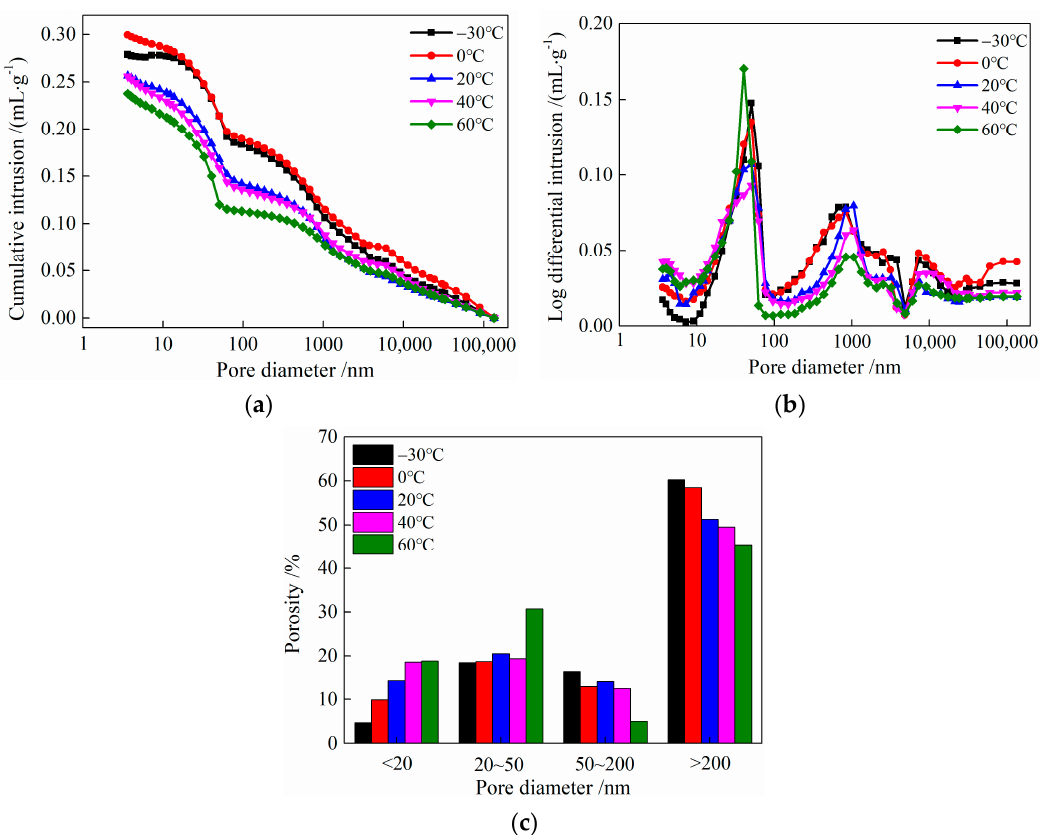
Figure 18. Pore size distribution of HDC. ( a ) Cumulative intrusion curve. ( b ) Log di ff erential intrusion curves. ( c ) Porosity.